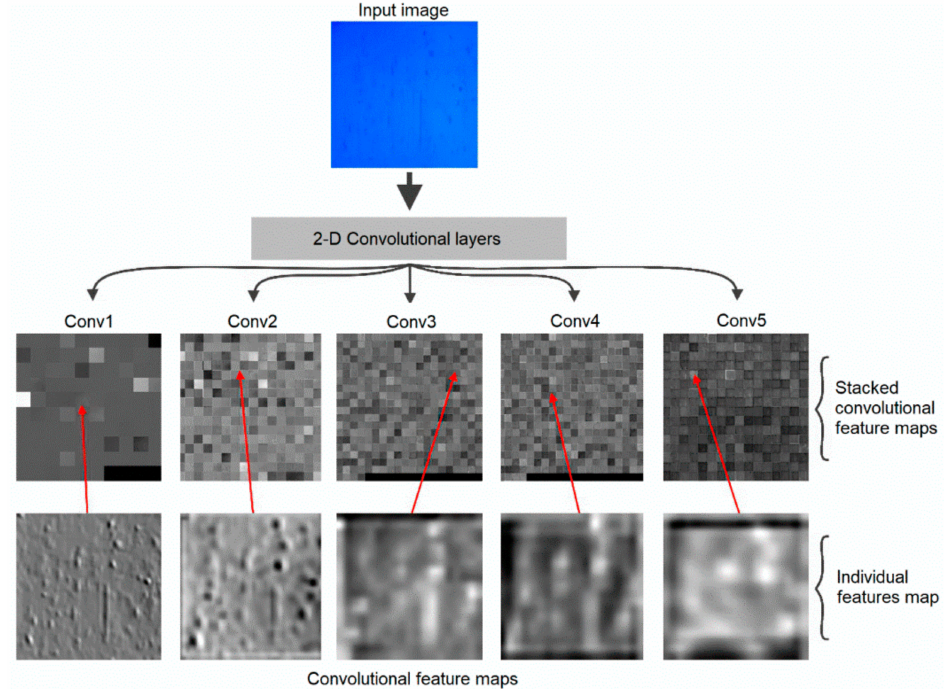
Figure 4. Convolutional feature maps of a liquid